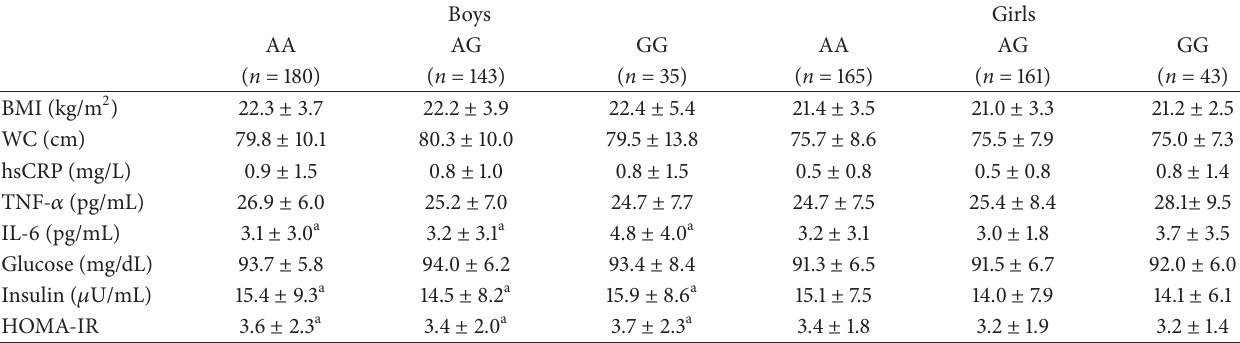
Table 4: Anthropometric and biochemical data with different AXL rs2304232 genotypes among boys and